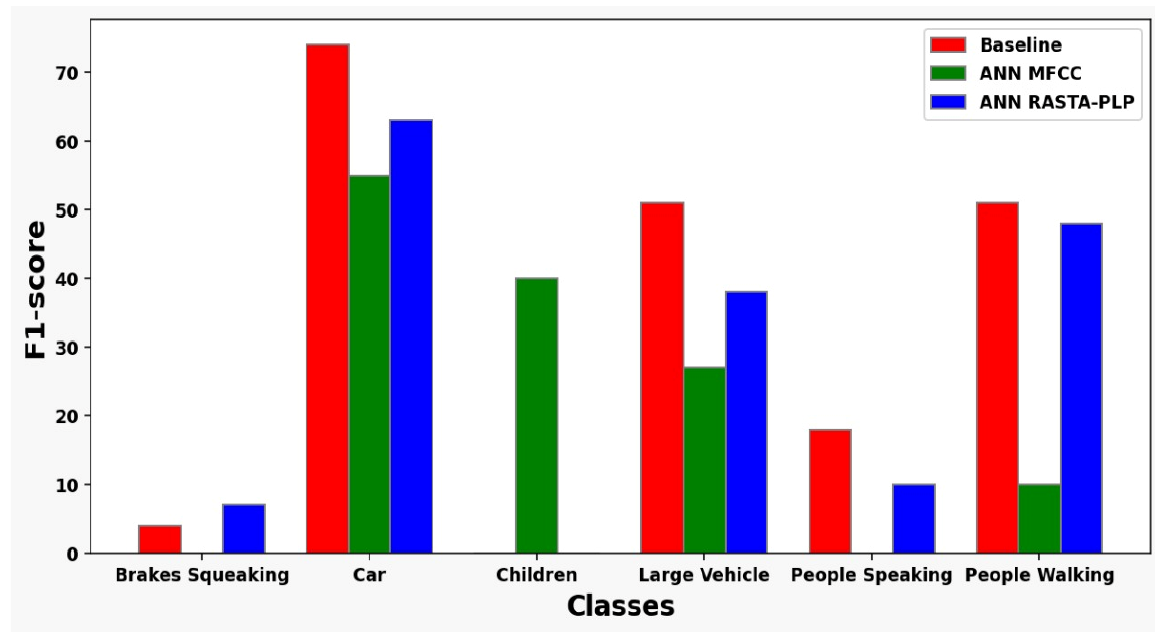
Figure 6. F1-score comparison using ANN classifier